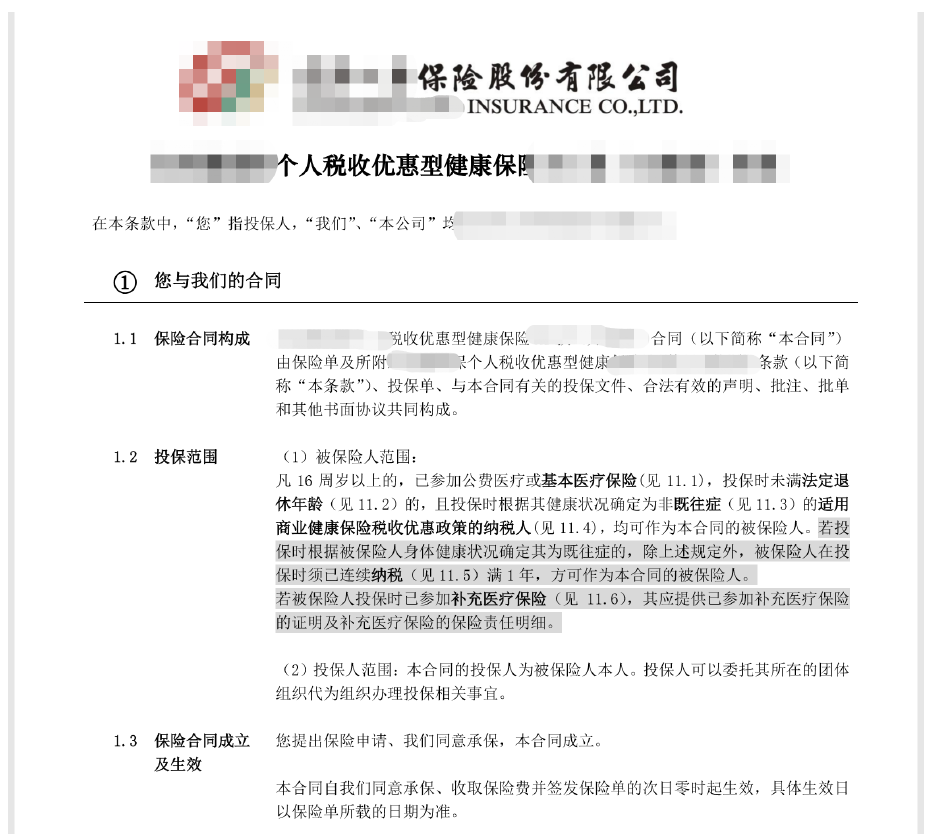
Figure A1. A typical original Chinese insurance document in PDF